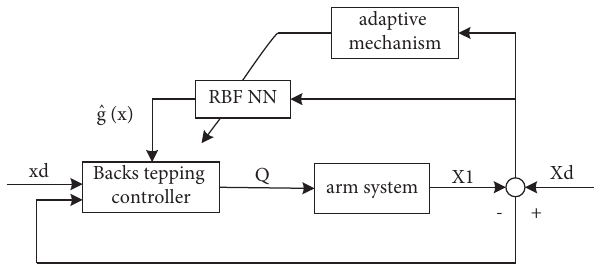
Figure 2: NN-based adaptive backstepping control scheme of the arm system.